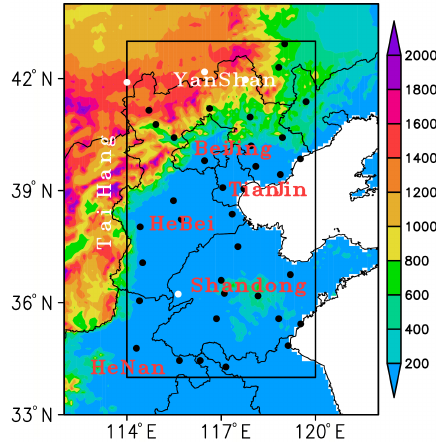
Figure 1. Topographic map (shading; unit: m) of North China and the locations of 39 NCP observation sites (urban: black circle; rural: white circle). The NCP area is represented by a black rectangle, and the names of provinces and mountains are written in red and white,